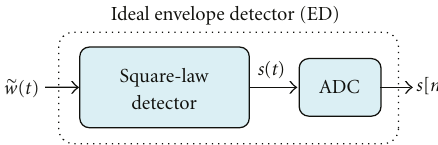
Figure 9: Block diagram of internal ideal ED